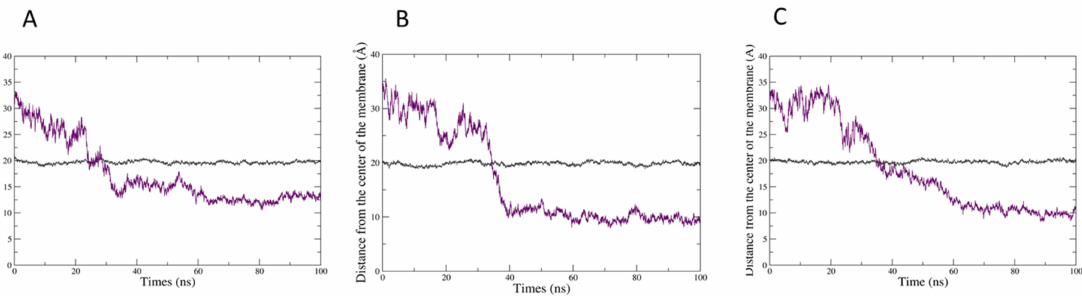
Figure 5. Evolution of the mean distance (in Angstroms) between the centre of the bilayer andthephosphategroupsofPLPC(darkgreycurve)andthatof( A )13moleculesofCIN,( B )13molecules of CitA, and ( C ) 13 molecules of CitO (purple curve).